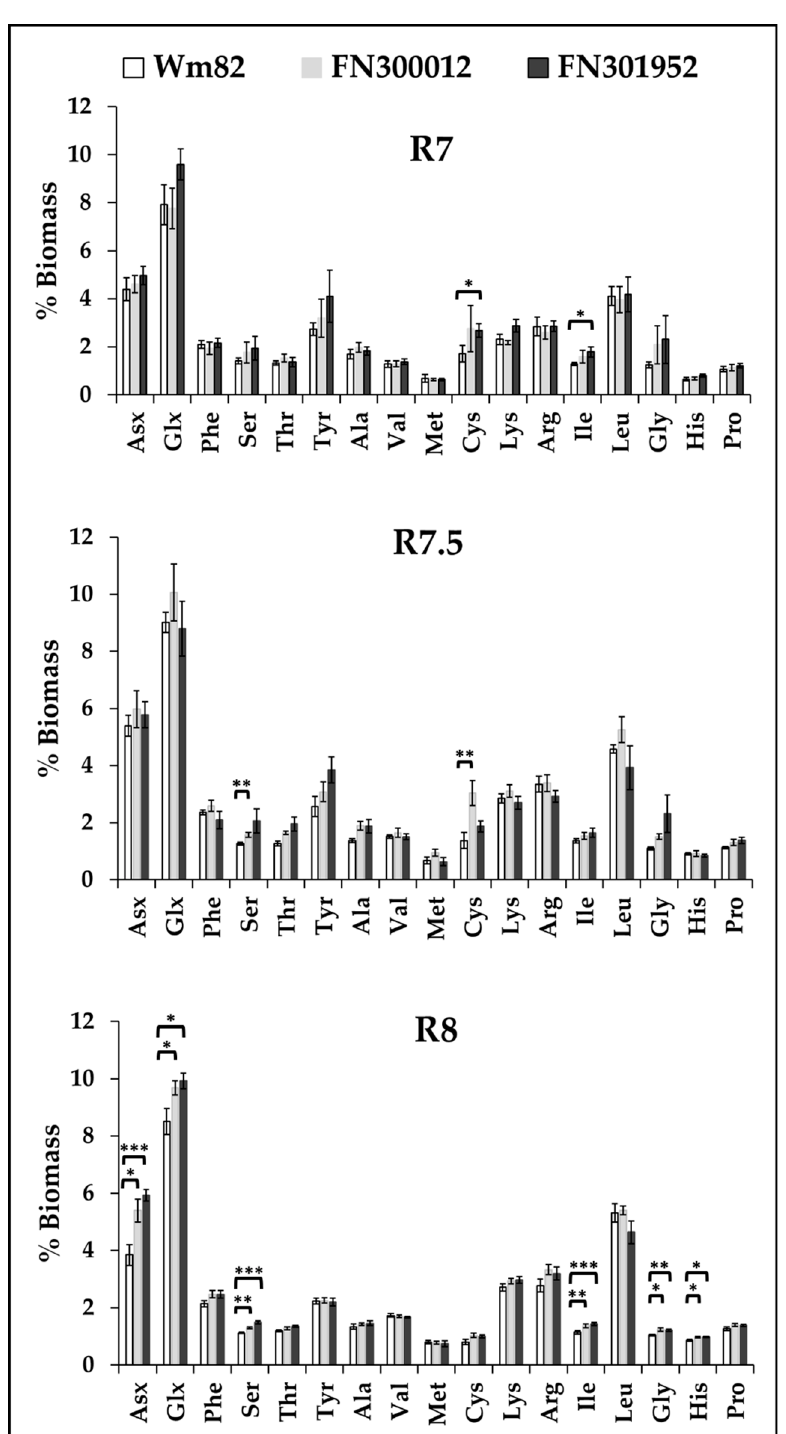
Figure 6. Amino acid composition of the total protein between the three lines, Williams 82, FN300012, and FN301952, at R7 (beginning of maturation), R7.5 (mid-maturation), and R8 (maturity). Values represent a mean ( n = 6). Student’s t -test was used for statistical analyses between the wild type and the two mutants. * p < 0.05, ** p < 0.01, and *** p < 0.001.